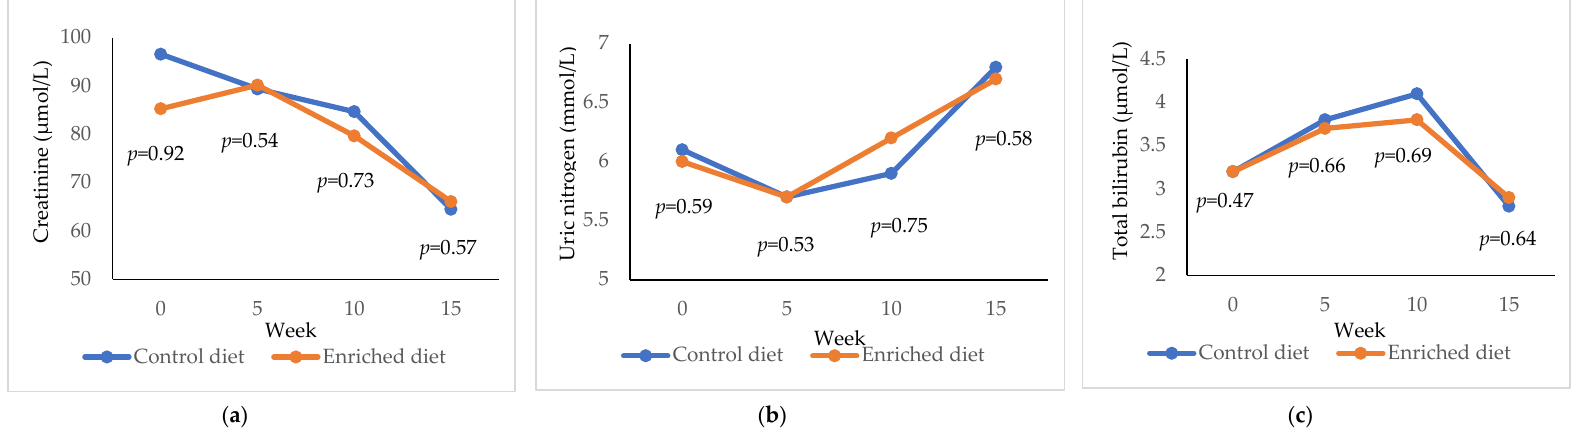
Figure 5. Evolution of ( a ) creatinine; ( b ) uric nitrogen; ( c ) total bilirubin in males fed with Control and Enriched diet. p is the probability of the difference being >0 when the difference between the diets was >0 or being <0 when this difference was